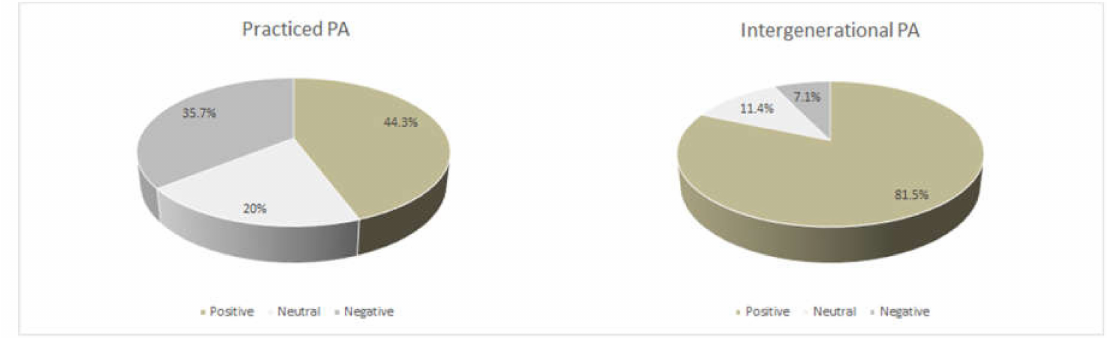
Figure 1. Enjoyment for physical activity.